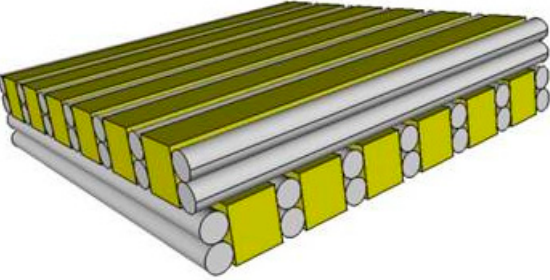
Figure 2. Scheme of a hard-soft phase scaffold with the hard thermoplastic phase (grey) and the soft hydrogel phase (yellow) containing the cells.